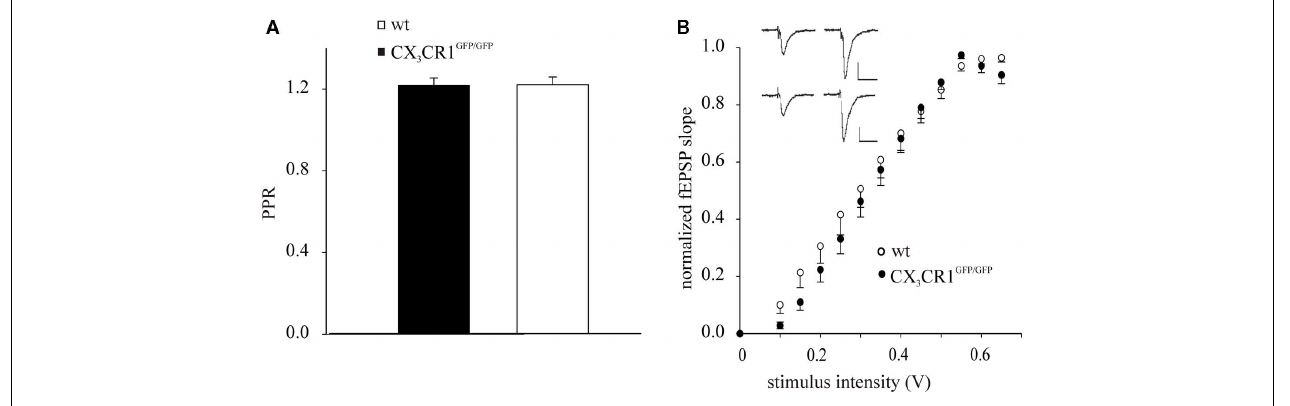
response curves (I–O) in wt and CX 3 CR1 GFP/GFP mice. fEPSP in the CA1 area was increased in slope in an intensity-dependent manner. Inset: sample recordings at 0.3 (left) and 0.6Volt (right) stimulation intensity in either wt (upper) or CX 3 CR1 GFP/GFP mice (lower); scale vertical bar: 0.5mV; scale horizontal bar: